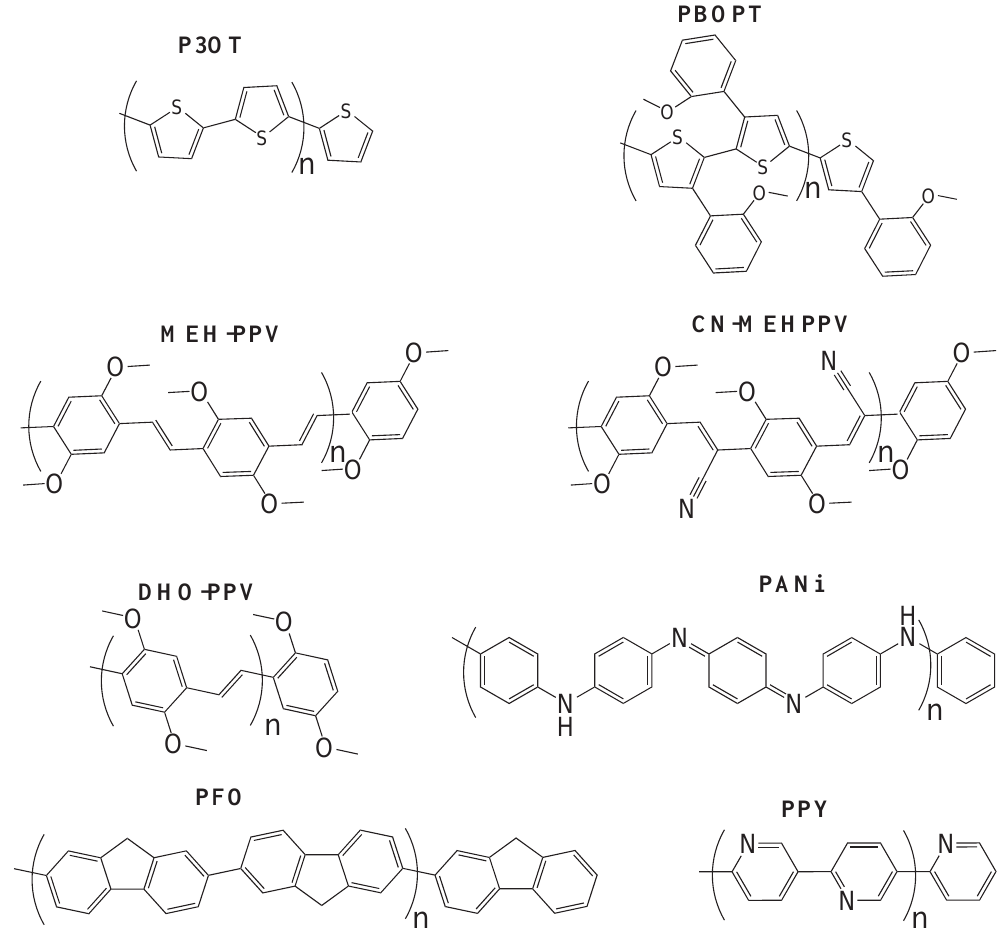
Figure 6. Chemical structures of the computationally studied light-emitting congugated